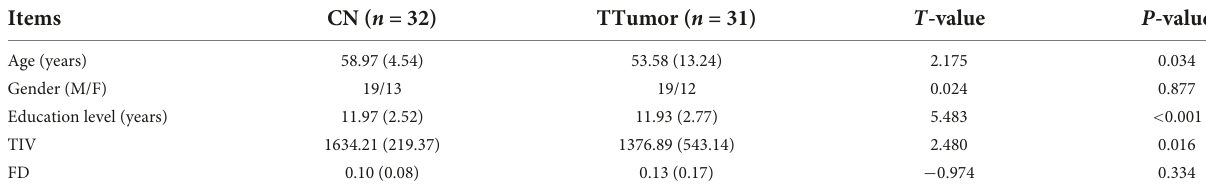
Values are expressed as the mean (standard deviation: SD). CN, healthy controls; TTumor, patients with temporal tumor (glioma); FD, framewise displacement; TIV, total intracranial